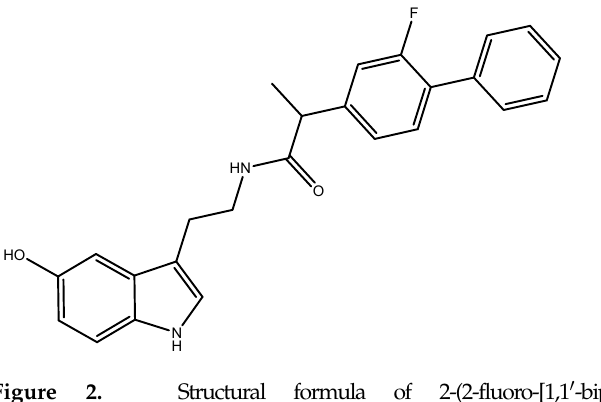
Figure 2. Structural formula of 2-(2-fluoro-[1,1’-biphenyl]-4-yl)- N -(2-(5-hydroxy-1 H -indol-3- 2. Structural formula of 2-(2-fluoro-[1,1 (cid:48) -biphenyl]-4-yl)- N -(2-(5-hydroxy-1 H -Indol-3- yl)ethyl)propanamide.